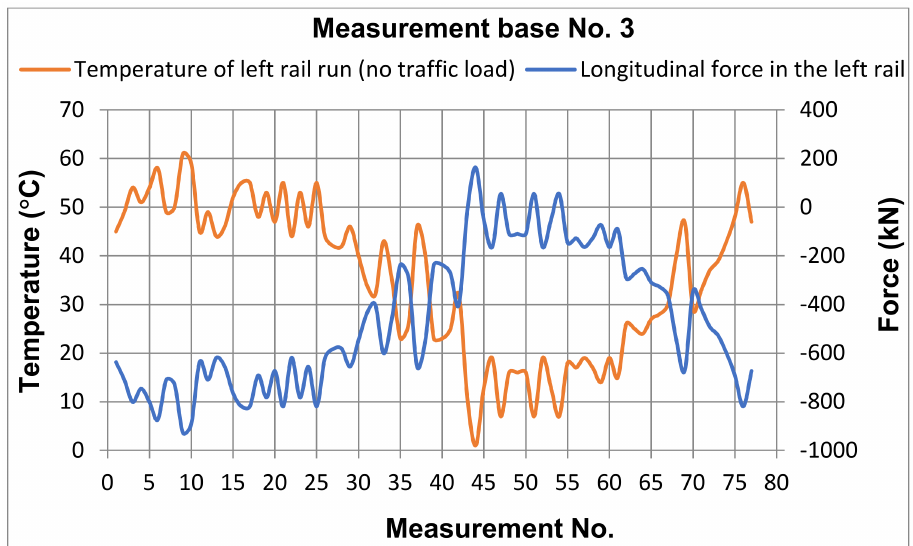
Figure 12. Results of measurements of temperature and longitudinal force of left rail without load of a passing train—measurement base No. 3 (source: own work).